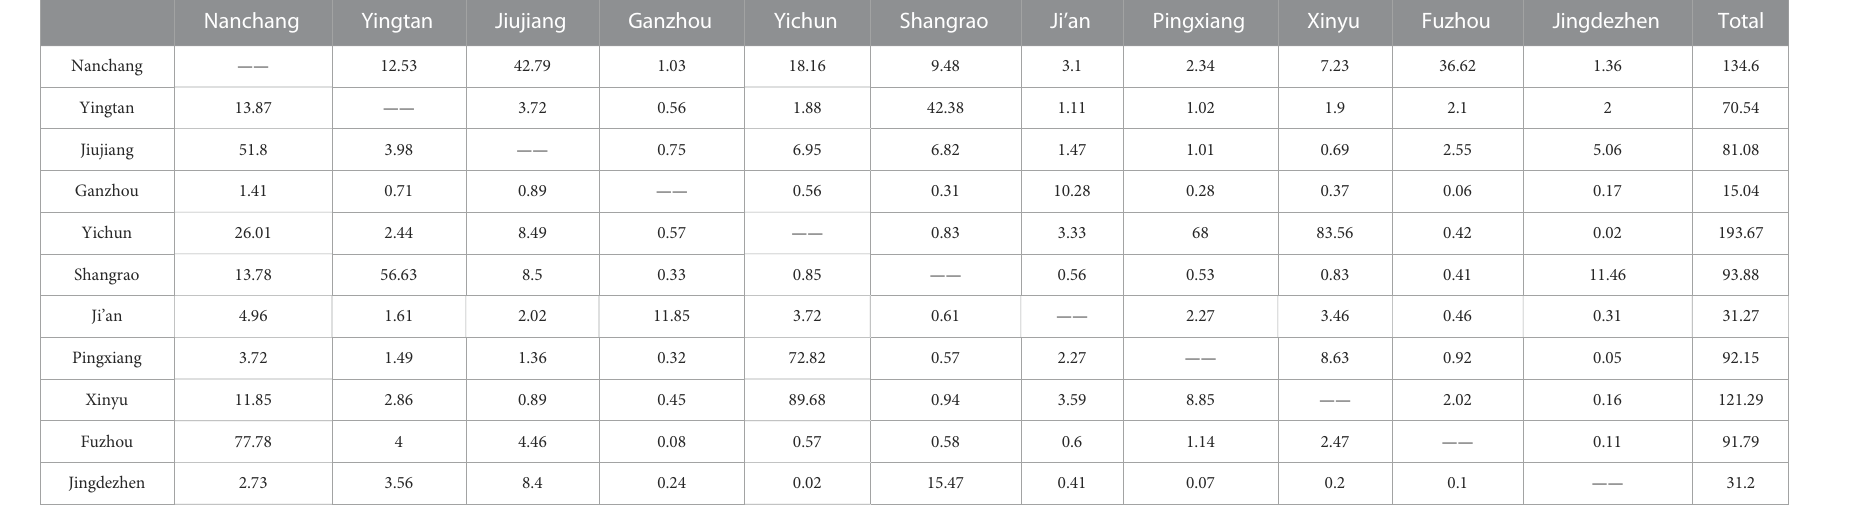
TABLE 9 Economic connections of 11 cities in Jiangxi Province after the opening of high-speed rail. Nanchang Yingtan Jiujiang Ganzhou Yichun Shangrao Ji ’ an Pingxiang Xinyu Fuzhou Total Nanchang